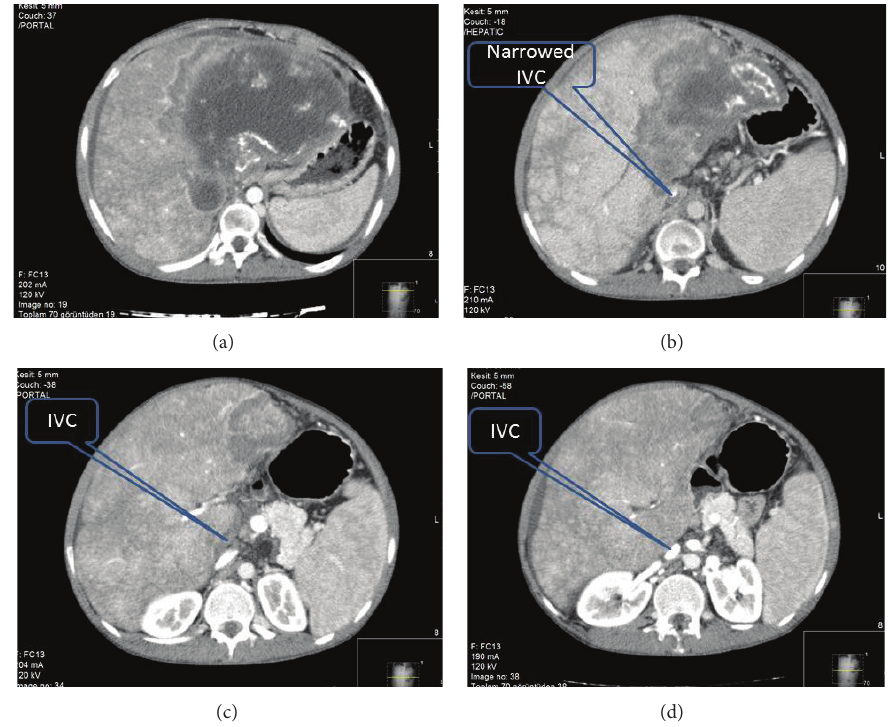
Figure 1: CT view of preoperative liver with (a) large mass filling almost all liver and IVC is nonvisible. (b) Invasion and compression of IVC by EA are seen. (c) Compression to surrounding tissues and organs by EA. (d) Compression and invasion of IVC extending up to renal vein level.